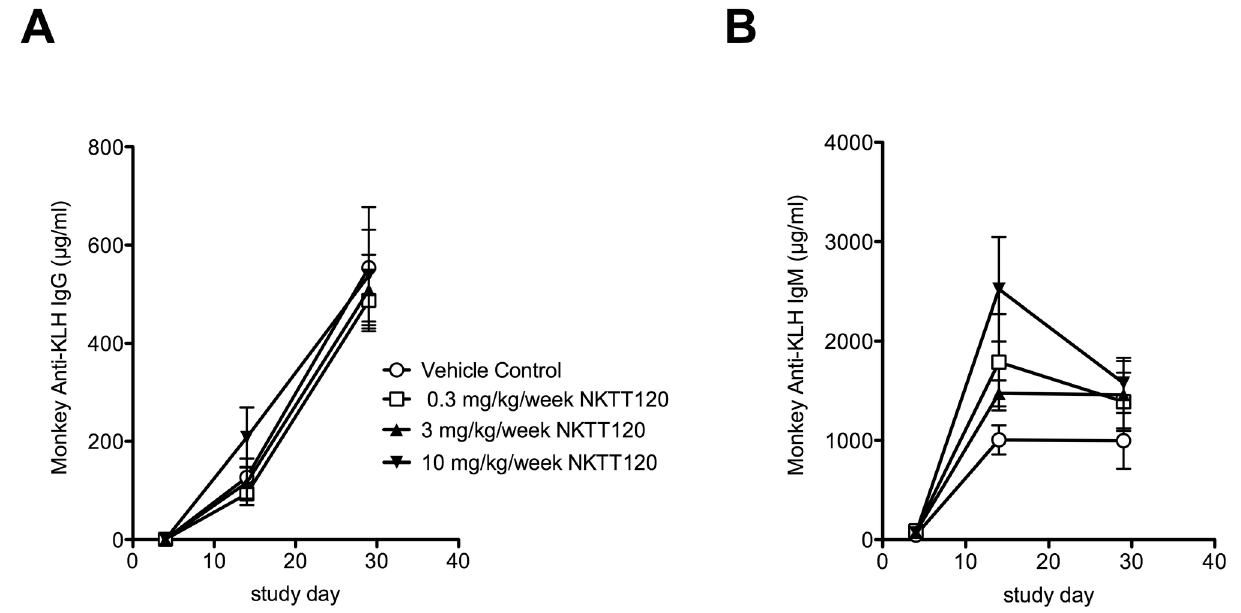
Figure 7. NKTT120 was administered to cynomolgus macaques (3-5/sex/group) at 0, 0.3, 3, and 10 mg/kg/week via intravenous injection once weekly for 5 doses. Keyhole Limped Hemocyanin (KLH) (3 mg/mL, at a dose volume of 1 mL/animal) was administered subcutaneously between the shoulder blades of the monkeys on Study Days 4 and 19. Blood (processed to serum) for anti-KLH IgM and IgG measurements was collected on Study Days 4 (prior to KLH administration), 14, and 29; anti-KLH IgG ( A ) and IgM ( B ) antibody response was measured by ELISA. One way ANOVA with multiple comparison was performed using PRISM software. There was no significant difference in Antibody responses across all